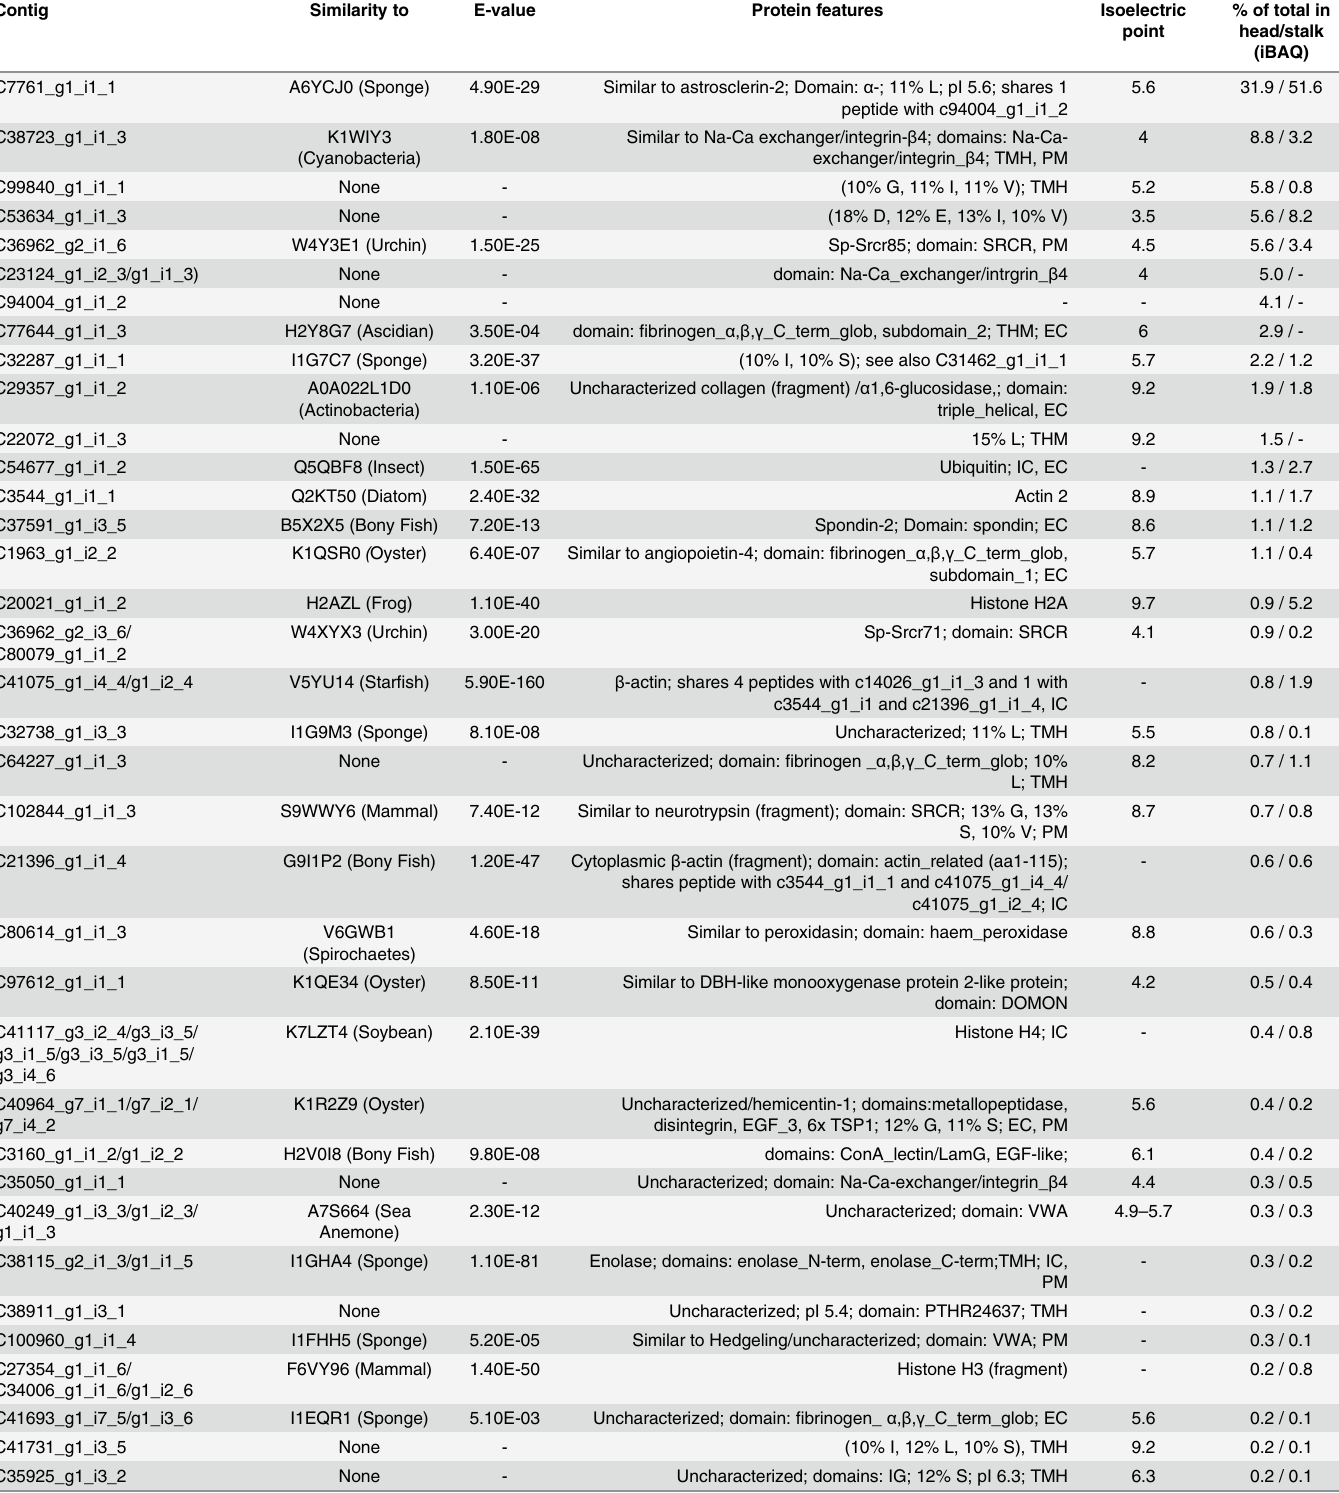
Table 1. The major proteins of the Vaceletia sp. head and stalk proteome: 40 proteins (with an iBAQ percentage more than 0.1) constitute more than 90% of the head and more than 87% of the stalk proteome. Contig Similarity to E-value Protein